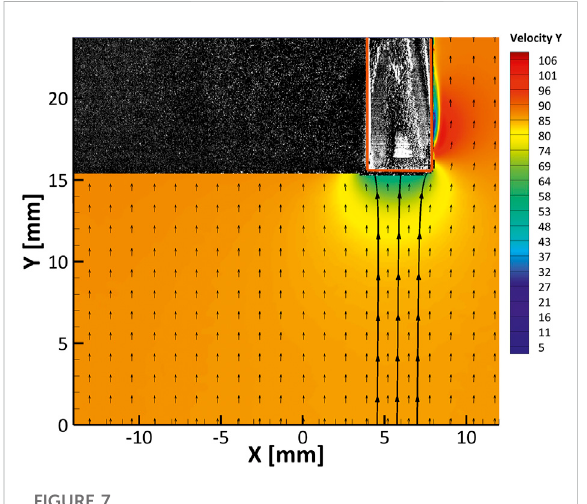
FIGURE 8 Axial velocity contours (m/s) with vector fi eld and streamtube overlaid on image of probe to show approximate location for the M = 0.25, θ = 20 ° test case. Sampling probe boundaries are highlighted in red.